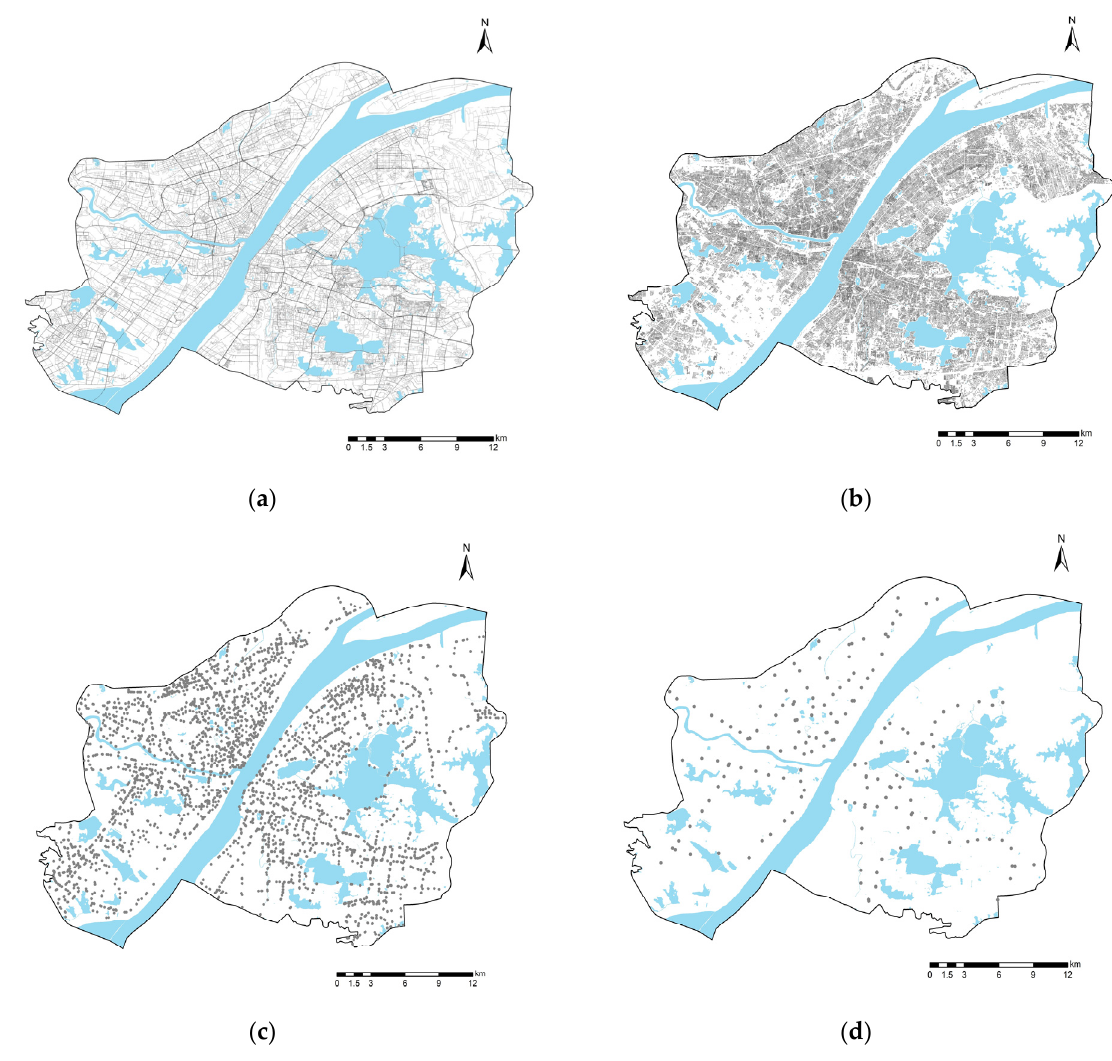
Figure 3. Basic data. ( a ) Road network data; ( b ) building data; ( c ) public transportation station data; ( d ) subway station